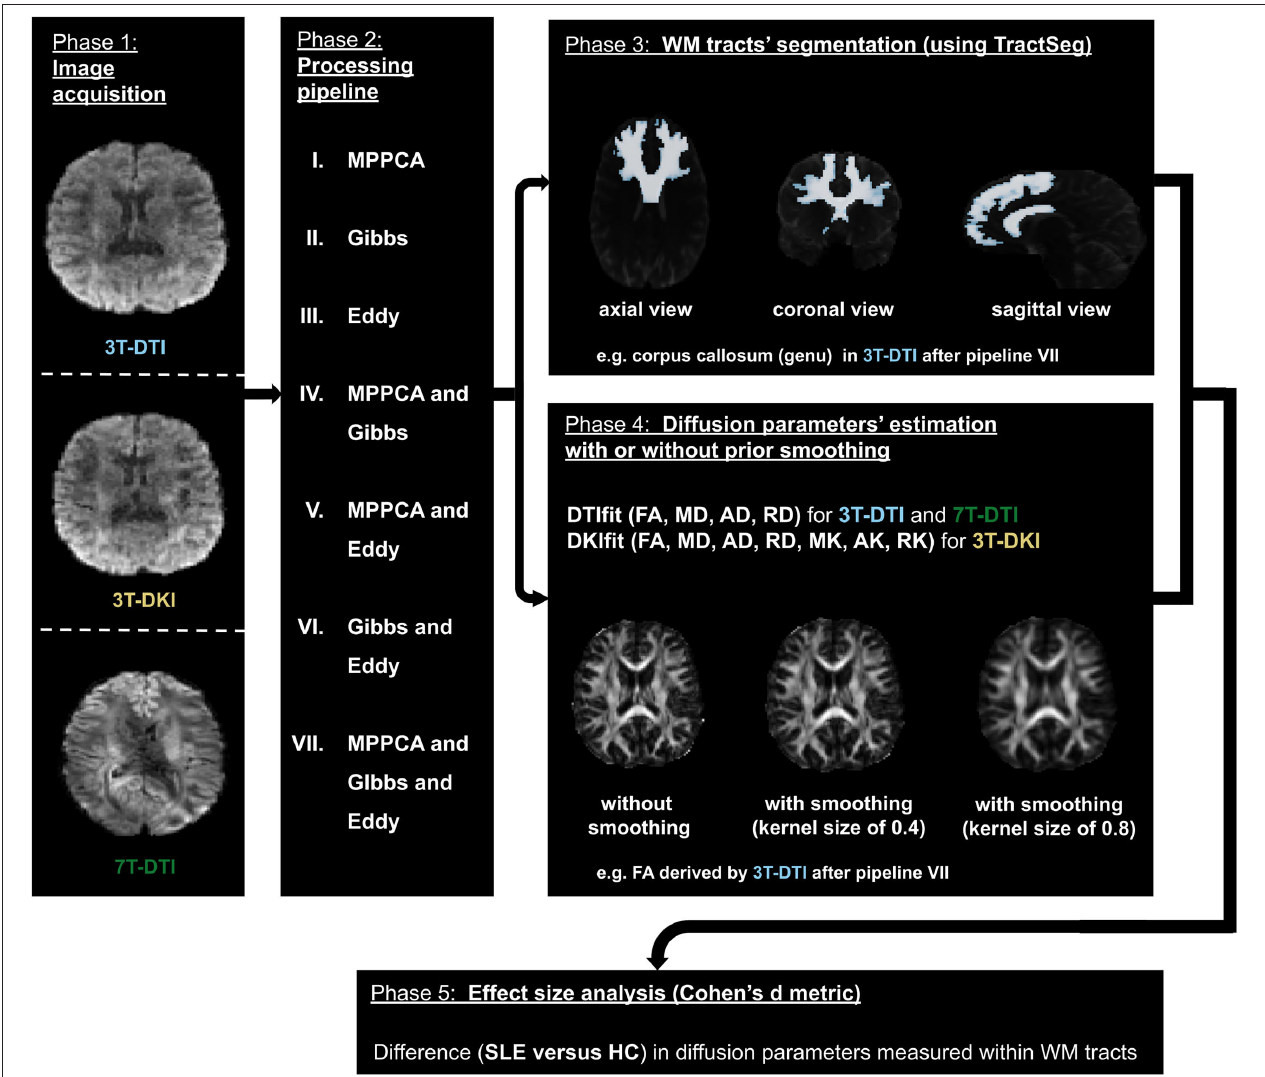
FIGURE 1 | The workflow. The diffusion MRI (dMRI) data were acquired using three different acquisition protocols: 3T-diffusion tensor imaging (DTI), 3T-diffusion kurtosis imaging (DKI), and 7T-DTI (left- most block). The three slices in the left block correspond to the same axial view of the dMRI volume with a b -value of 1,000 s / mm 2 in each of the three protocols. Subsequently, dMRI data were processed by seven different processing pipelines (a second block from the left). The processed data were then used by TractSeg to segment 72 major white matter (WM) tracts (top right most block). The processed dMRI data were also fitted using either DTI or DKI (depending on the initial acquisition) to extract dMRI parameters. To assess the impact of smoothing prior to model fitting, this fitting step was performed with different degrees of smoothing, ranging from no to substantial smoothing (right most block second from top). Finally, Cohen’s d was computed from the average and SD of the parameters within the 72 WM tracts segmented earlier (bottom block).